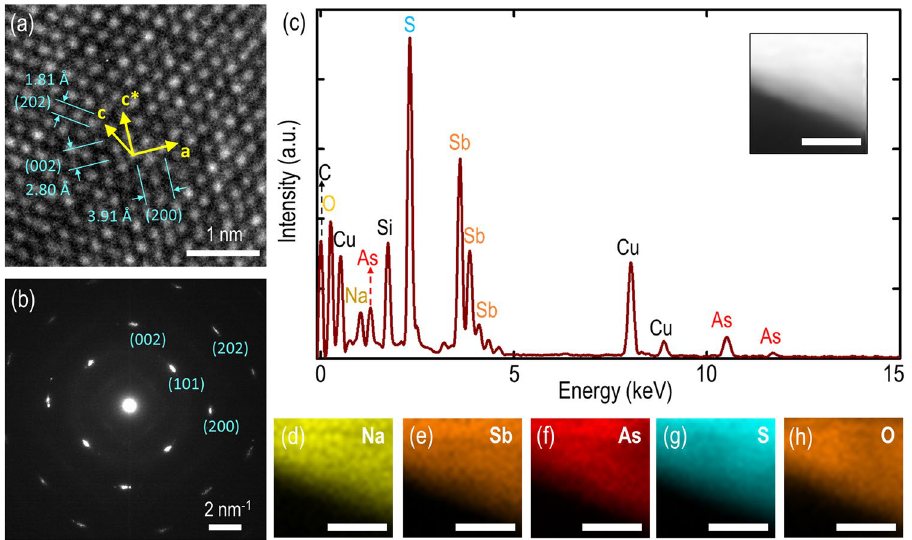
Figure 2. Atomic arrangement and chemical composition analysis. ( a ) Captured HRTEM image of an ultrathin gerstleyite crystal. ( b ) Corresponding SAED pattern emphasizing the crystalline nature of probed crystal. ( c ) Recorded average EDXS spectrum underlining the presence of prime elements (Na, Sb, As, S and O) in the examined crystal. The inset shows the dark-field TEM image of a crystal section used for capturing TEM- EDXS elemental maps. ( d – h ) TEM-EDXS elemental maps of major elements, emphasizing the homogenous distributions of these elements throughout the crystal. The scale bar indicates 50